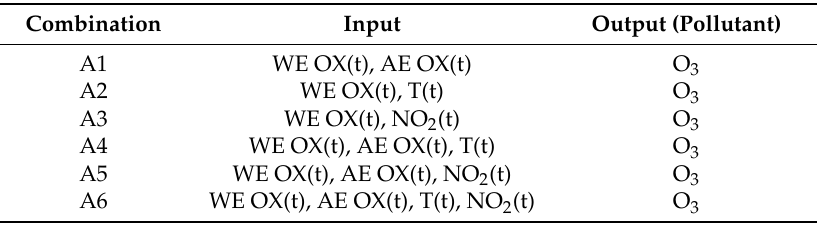
Table 3. Summary of the configuration input